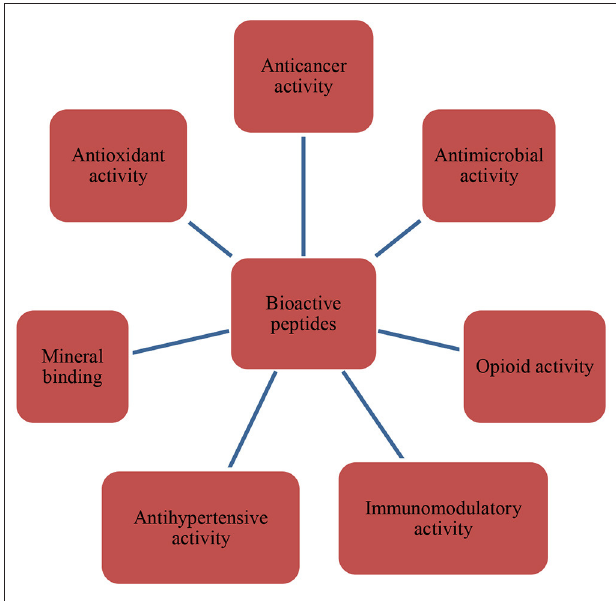
FIGURE 2 | Bioactivities of bioactive